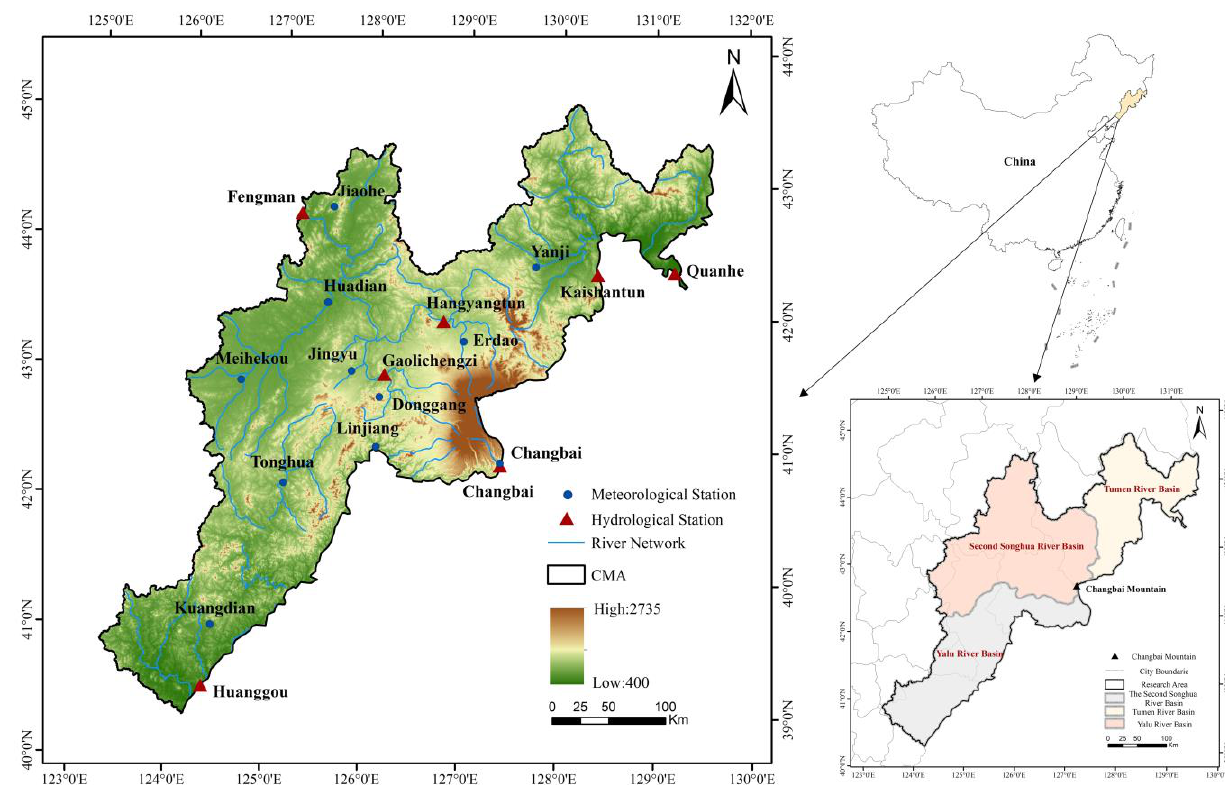
Figure 1. River networks and hydrological stations in the Changbai Mountain area (CMA).